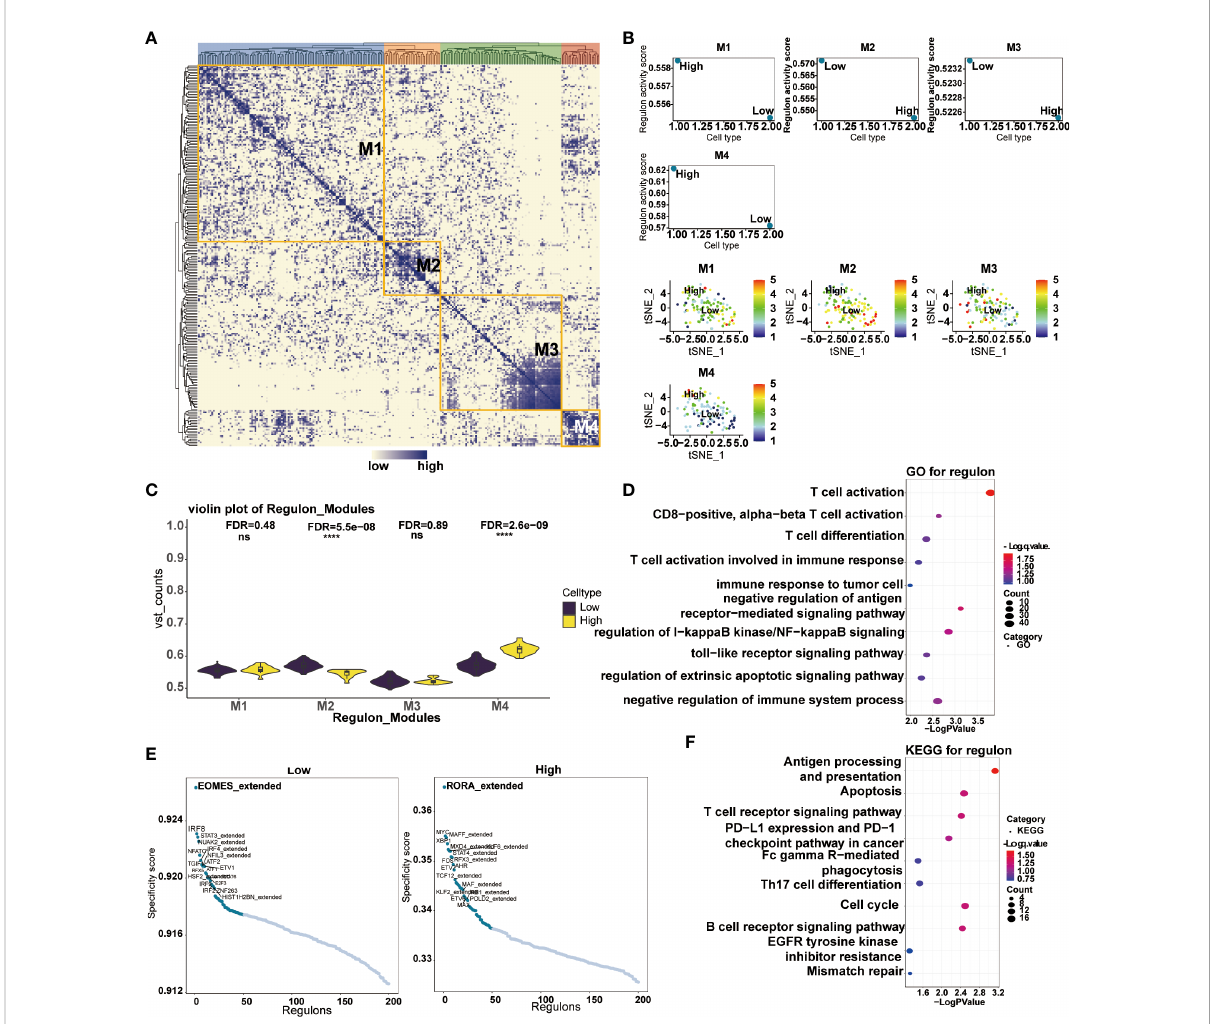
FIGURE 10 Correlation between transcription factors and CD161 expression in malignant cells. Heatmap of transcription factors in malignant tumor cells divided into four modules according to the ligation speci fi city index (A) . Regulon activity scores of transcription factors in CD161 high and CD161 low malignant neoplastic cells in four modules (B) . Violin plot of regulatory activity scores of transcription factors in CD161 high and CD161 low malignant cells in four modules (C) . GO enrichment analysis was performed to examine the possible functions of high expression regulons in malignant tumor cells (D) . Scatter plots based on transcription factor speci fi city scores in malignant cells expressed in CD161 high and CD161 low groups (E) . KEGG enrichment analysis was performed to examine the possible functions of high expression regulons in malignant tumor cells (F) . ns, not statistically signi fi cant; ****P